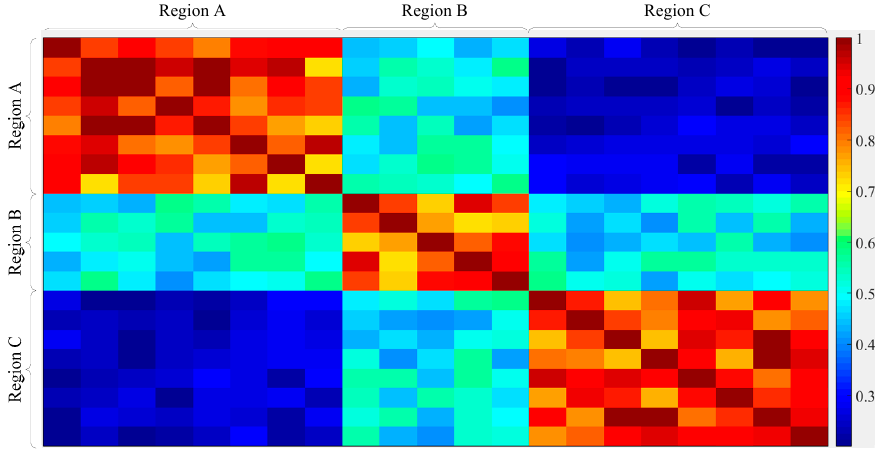
Figure 7. The correlations of the line ratings in the enhanced IEEE RTN.